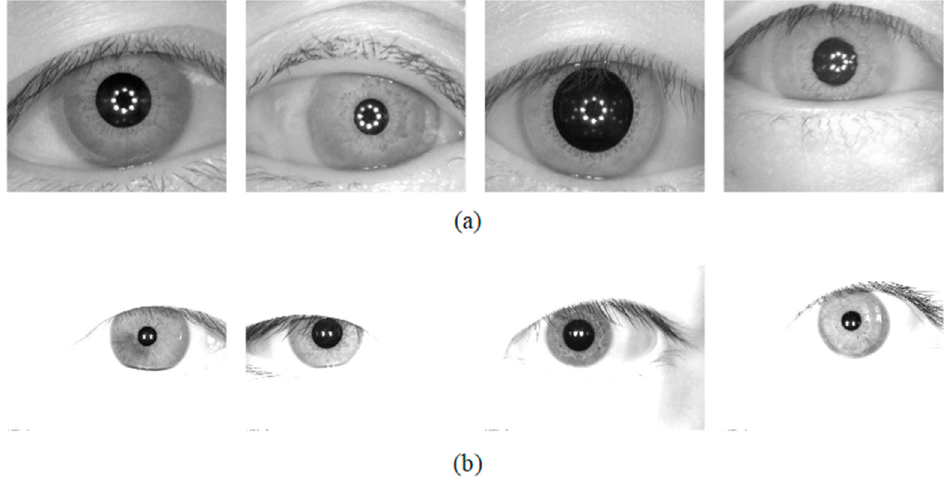
Figure 8. Image samples from the adopted iris databases ( a ) CASIA-v4.0 and ( b ) JLU-4.0.